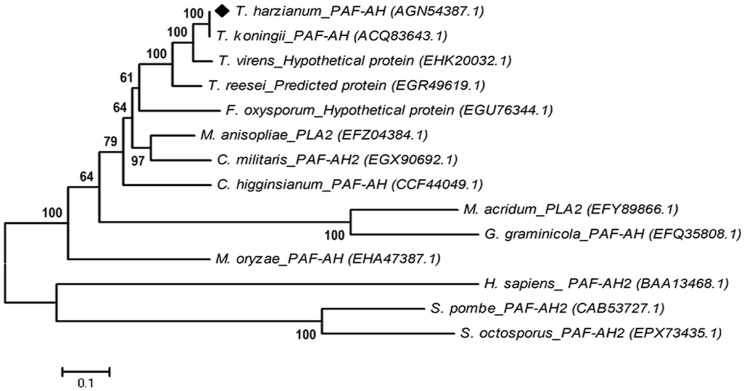
Phylogenetic neighbor-joining (NJ) tree of the PAF-AH protein sequences.The phylogenetic NJ tree was generated with MEGA 5.1 software from alignments of protein sequences obtained using CLUSTAL W. The PAF-AH protein from T. harzianum T28 (marked with a black square) and related proteins of representative strains from the GenBank database are shown.